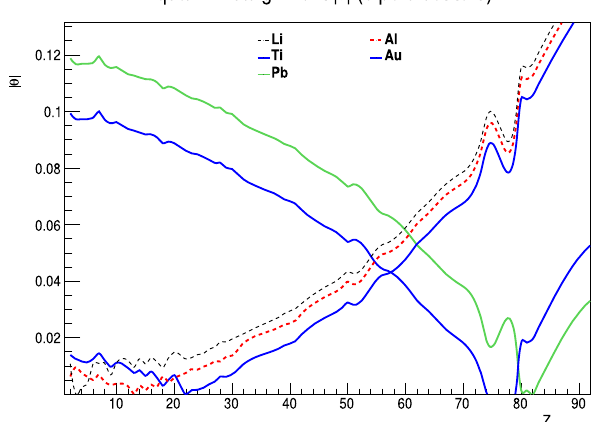
Fig. 7 The misalignement angle θ (defined in Eq. (A.12) between quark target vectors; notice the reduced vertical scale and smoother lines as compared to the nucleon plot. The decreasing lines are lead (green, upper) and Au (blue); the rising lines are titanium (blue) and Al (red, dashed, middle) and lithium (black, dashed,